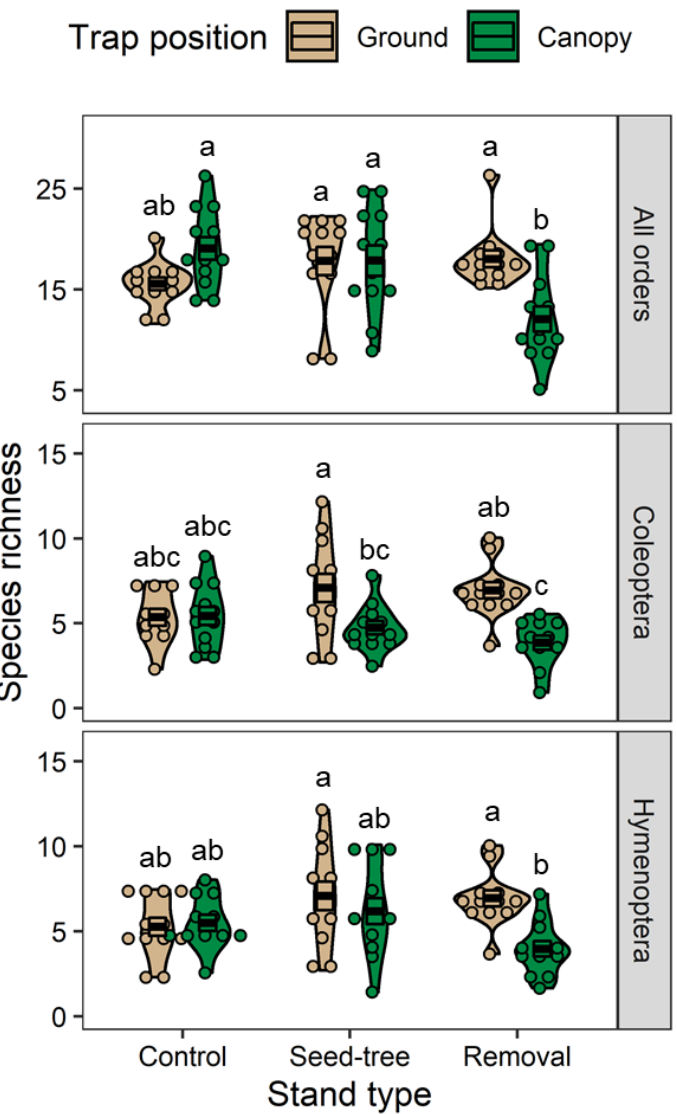
Figure 4. Crossbars (mean ± SE) and violin plots (probability density), including individual measures (n = 12 traps per group) of species richness for all insect orders combined, Coleoptera, and Hymenoptera. Values in each panel are compared due to the significant interaction between trap position and stand type. Groups with different letters indicate significant differences ( p < 0.05, Tukey – Kramer test).